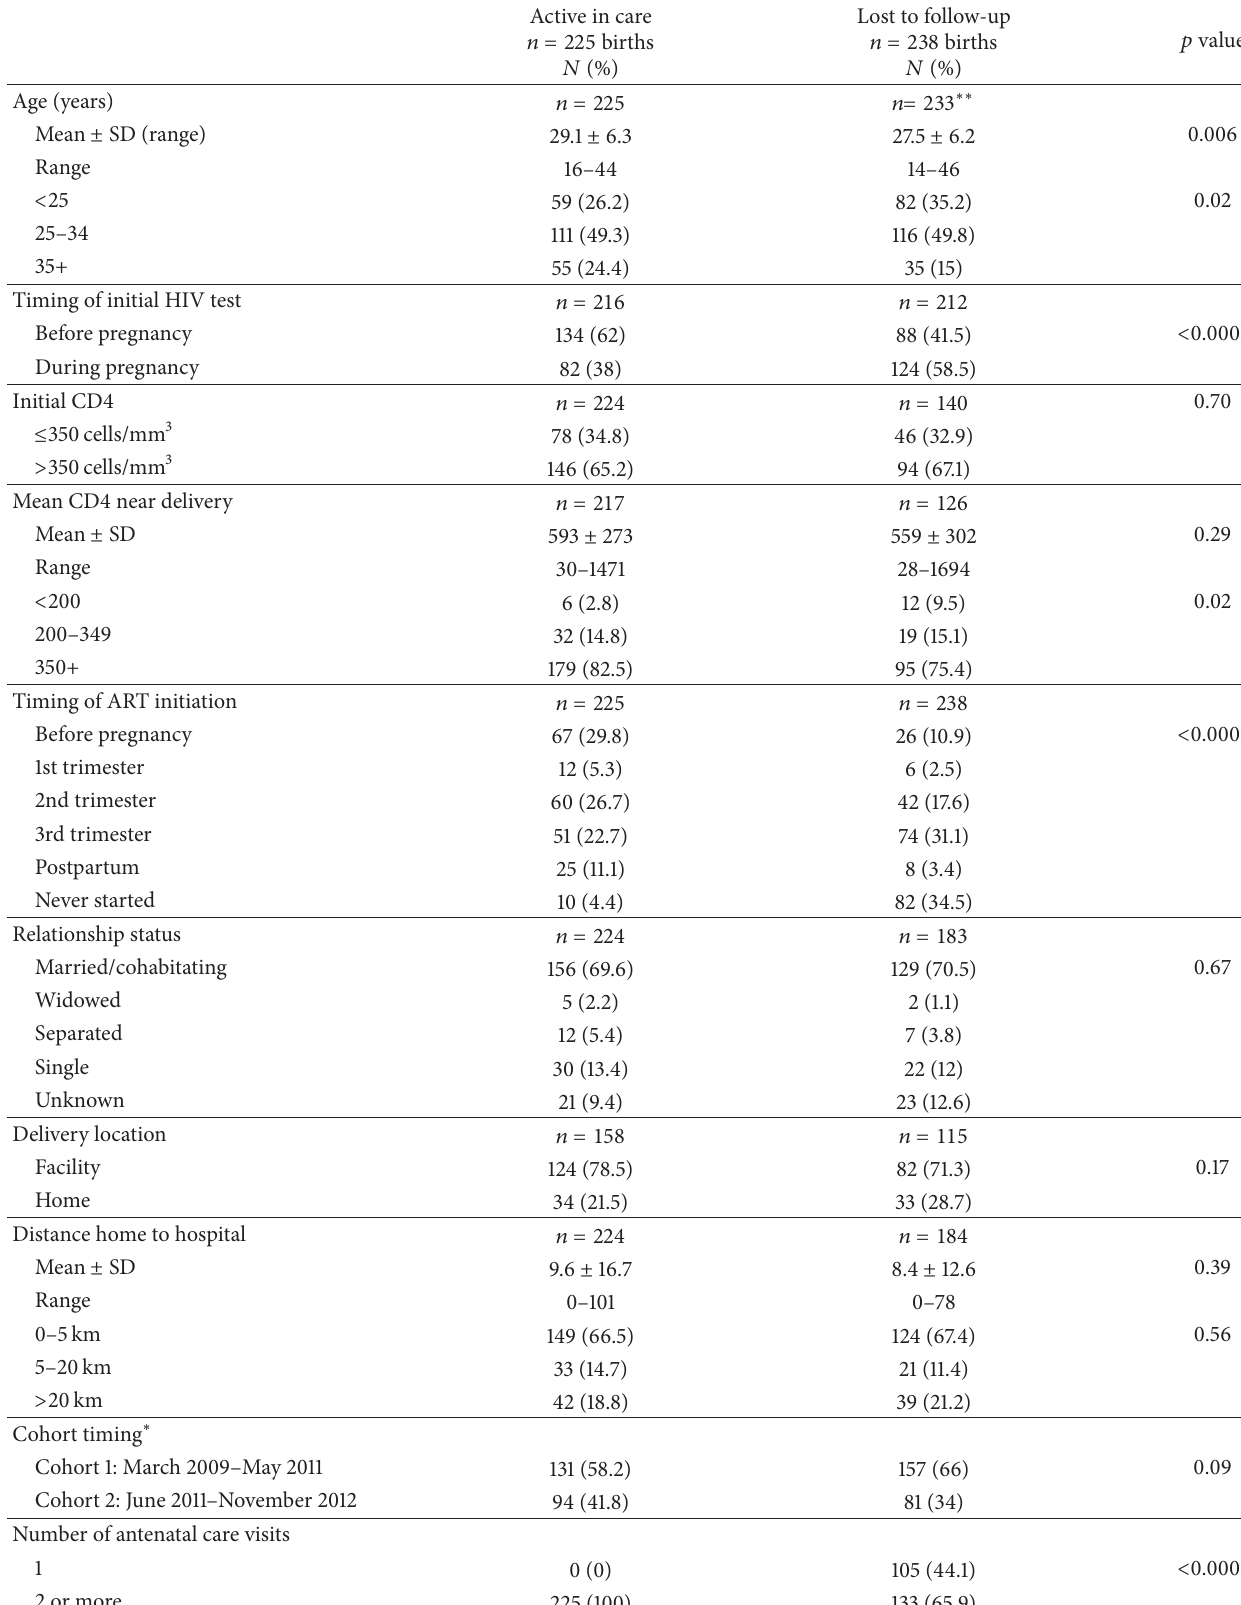
Table 1: Participant characteristics ∗∗